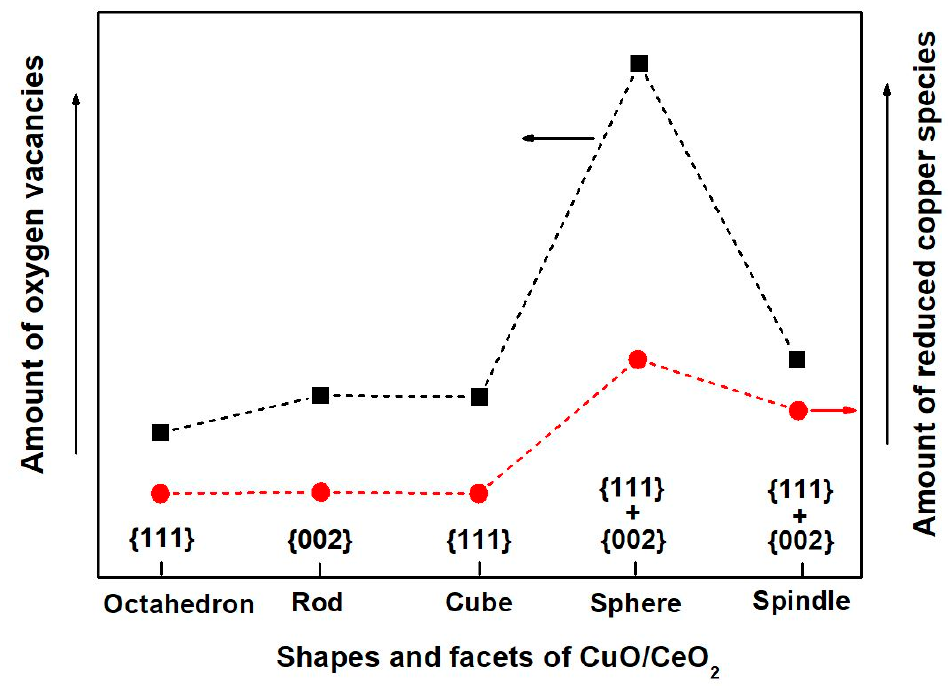
Figure 17. Plots of the number of oxygen vacancies and reduced copper species for the CuO/CeO 2 catalysts with different support shapes. Adapted from Reference [116]. Copyright© 2018, Elsevier.